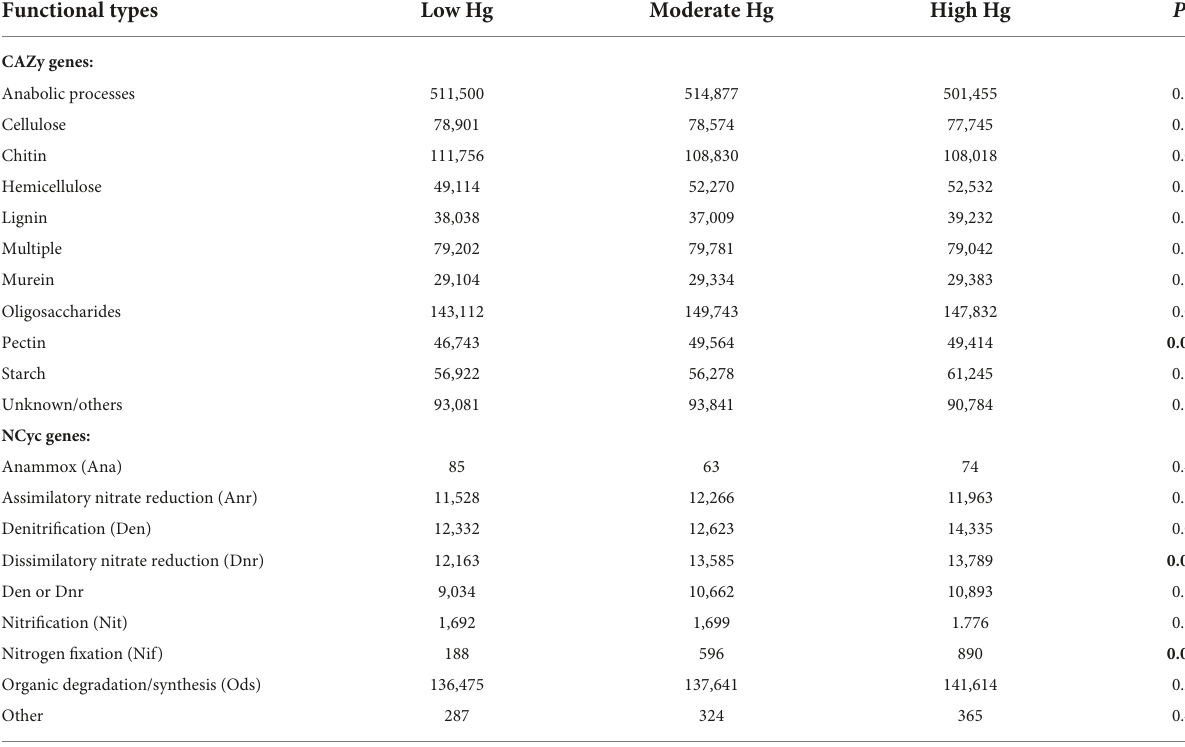
TABLE 6 Normalized counts of genes of the CAZy and NCyc databases of soils with the three different Hg contamination levels ( n = 3). Functional types